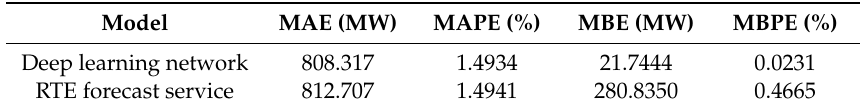
Table 2. Performance comparison metrics. MAE: mean absolute error; MAPE: mean absolute